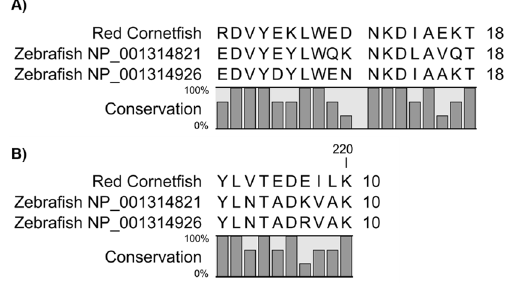
Figure 1. Identification of putative zebrafish ( Danio rerio ) thiaminases. Sequence alignment of previously reported thiaminase I peptide fragments from red cornetfish ( Fistularia petimba ) with candidate zebrafish thiaminase I protein sequences. ( A ) N-terminal thiaminase I peptide fragment from red cornetfish aligned with residues 25–40 of zebrafish protein NP_001314821 and residues 39–56 of zebrafish protein NP_001314926. ( B ) Internal thiaminase I peptide fragment from red cornetfish aligned with residues 195–204 of zebrafish protein NP_001314821 and residues 210–219 of zebrafish protein